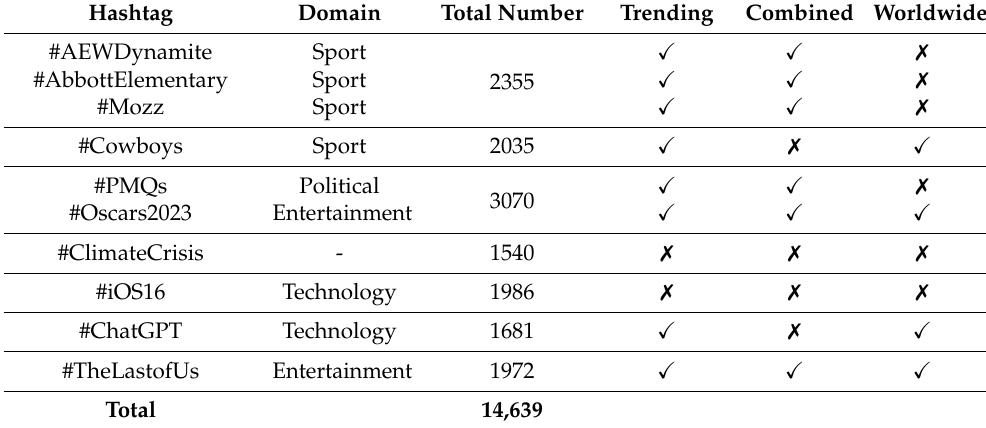
Table 2. Group 2